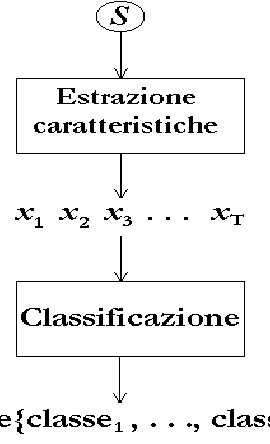
Figura 1 – Sistema di riconoscimento basato sull’estrazione di caratteristiche dal segnale S (dia- gramma